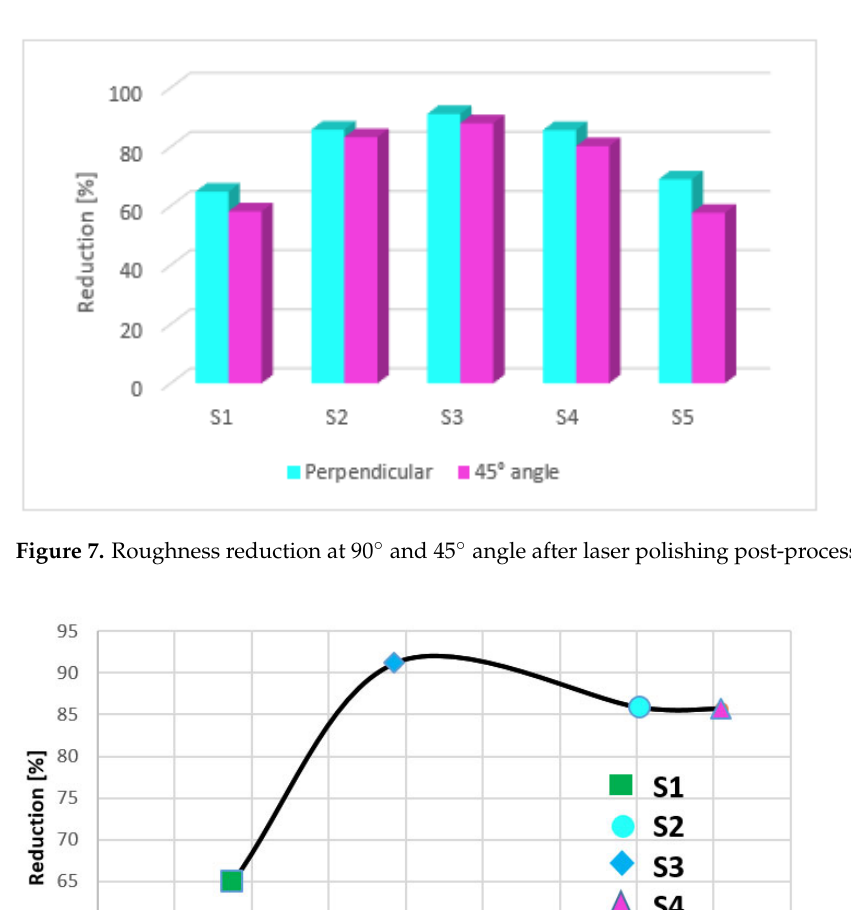
Figure 6. Roughness measurements at 90° and 45° angles for the investigated specimens following laser polishing post ‐ processing using different ED.